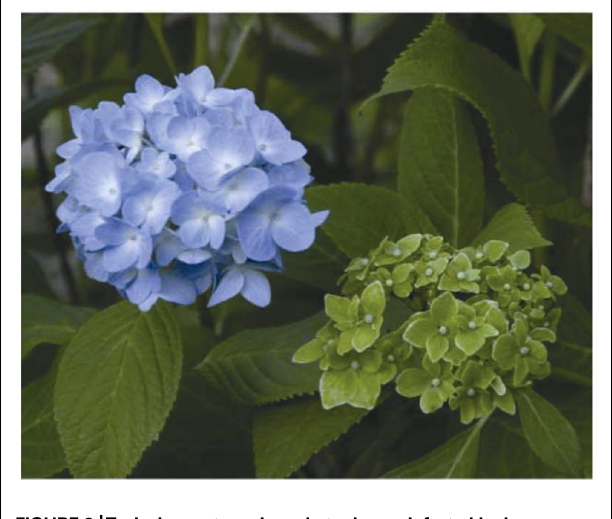
FIGURE 1 | Electron microphotograph of Candidatus Phytoplasma asteris infecting the plant phloem. A section of phloem tissue from an infected plant vascular bundle is shown. Several of the plant cells contain phytoplasma cells.